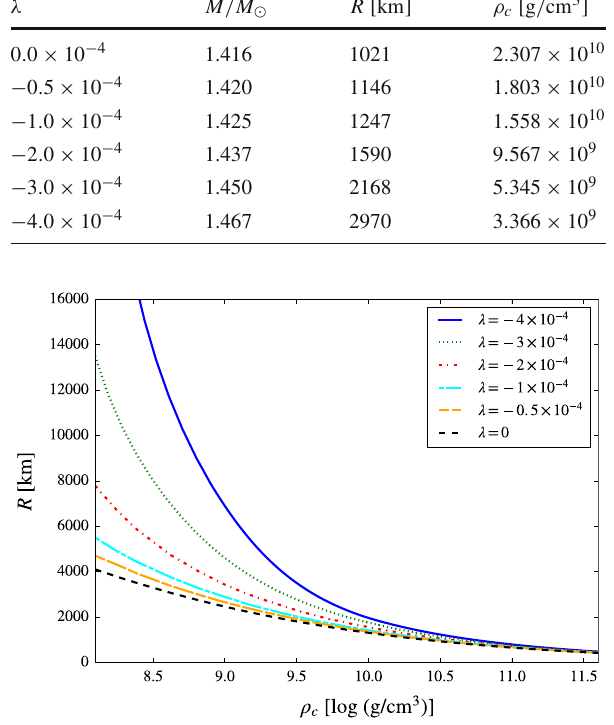
Fig. 5 The total star radius versus central density for different values of λ